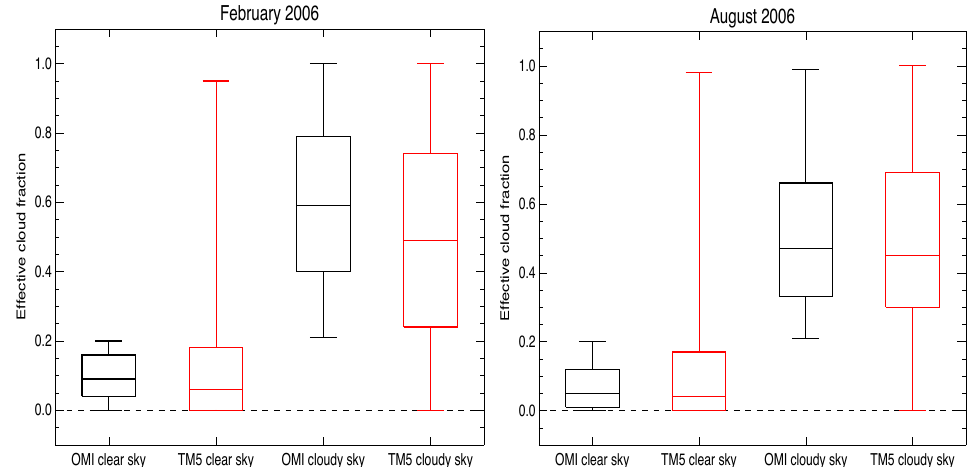
Figure 3. Box and whisker plots for OMI (black) and TM5 (red) effective cloud fractions over Europe in February 2006 (left panel) and August 2006 (right panel). The two left boxes of each panel indicate the clear-sky situations when the OMI cloud fraction < 0.2. The centreline of each box indicates the median cloud fraction, the upper and lower edges indicate the 25th and 75th percentiles and the lower and upper whiskers represent the minimum and maximum value in the sample. For February 2006, the sample consisted of 3379 pairs (737 clear sky, 2642 cloudy), and for August, the sample size was 4665 (1991 clear sky, 2674